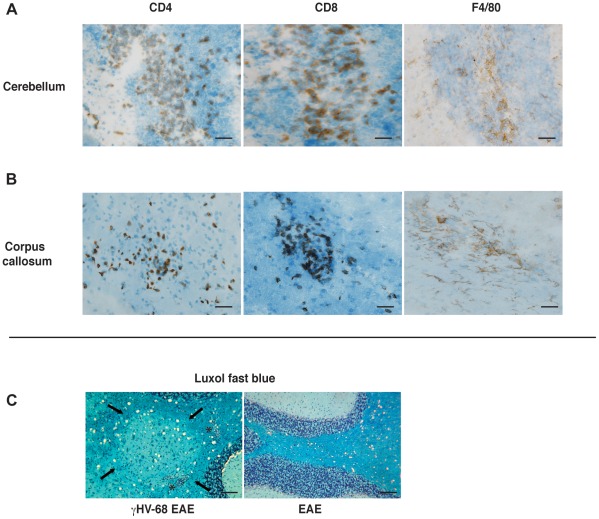
γHV-68 EAE mice show MS-like lesions in the white matter of the cerebellum and in the corpus callosum.Mice were infected with γHV-68 or MEM only. Five weeks p.i. EAE was induced. At day 28 post EAE induction mice were perfused and brains were embedded in OCT, snap frozen, cut and stained with antibodies specific for CD4, CD8 and F4/80; or were formalin fixed and embedded in paraffin and stained with luxol fast blue. (A–B) The images displayed for CD4-CD8-F4/80 staining are consecutive sections cut from the same cerebral hemisphere of the same mouse (all images from γHV-68 EAE mice). Scale bar: 50 µm. (C) The arrows show an area of demyelination in the cerebellum of a γHV-68 EAE mouse and the asterisks highlight immune cell infiltrations. The right panel shows a normal cerebellum from a naïve EAE mouse. Scale bar: 100 µm. All pictures are representative of two separate experiments (n = 16/group).